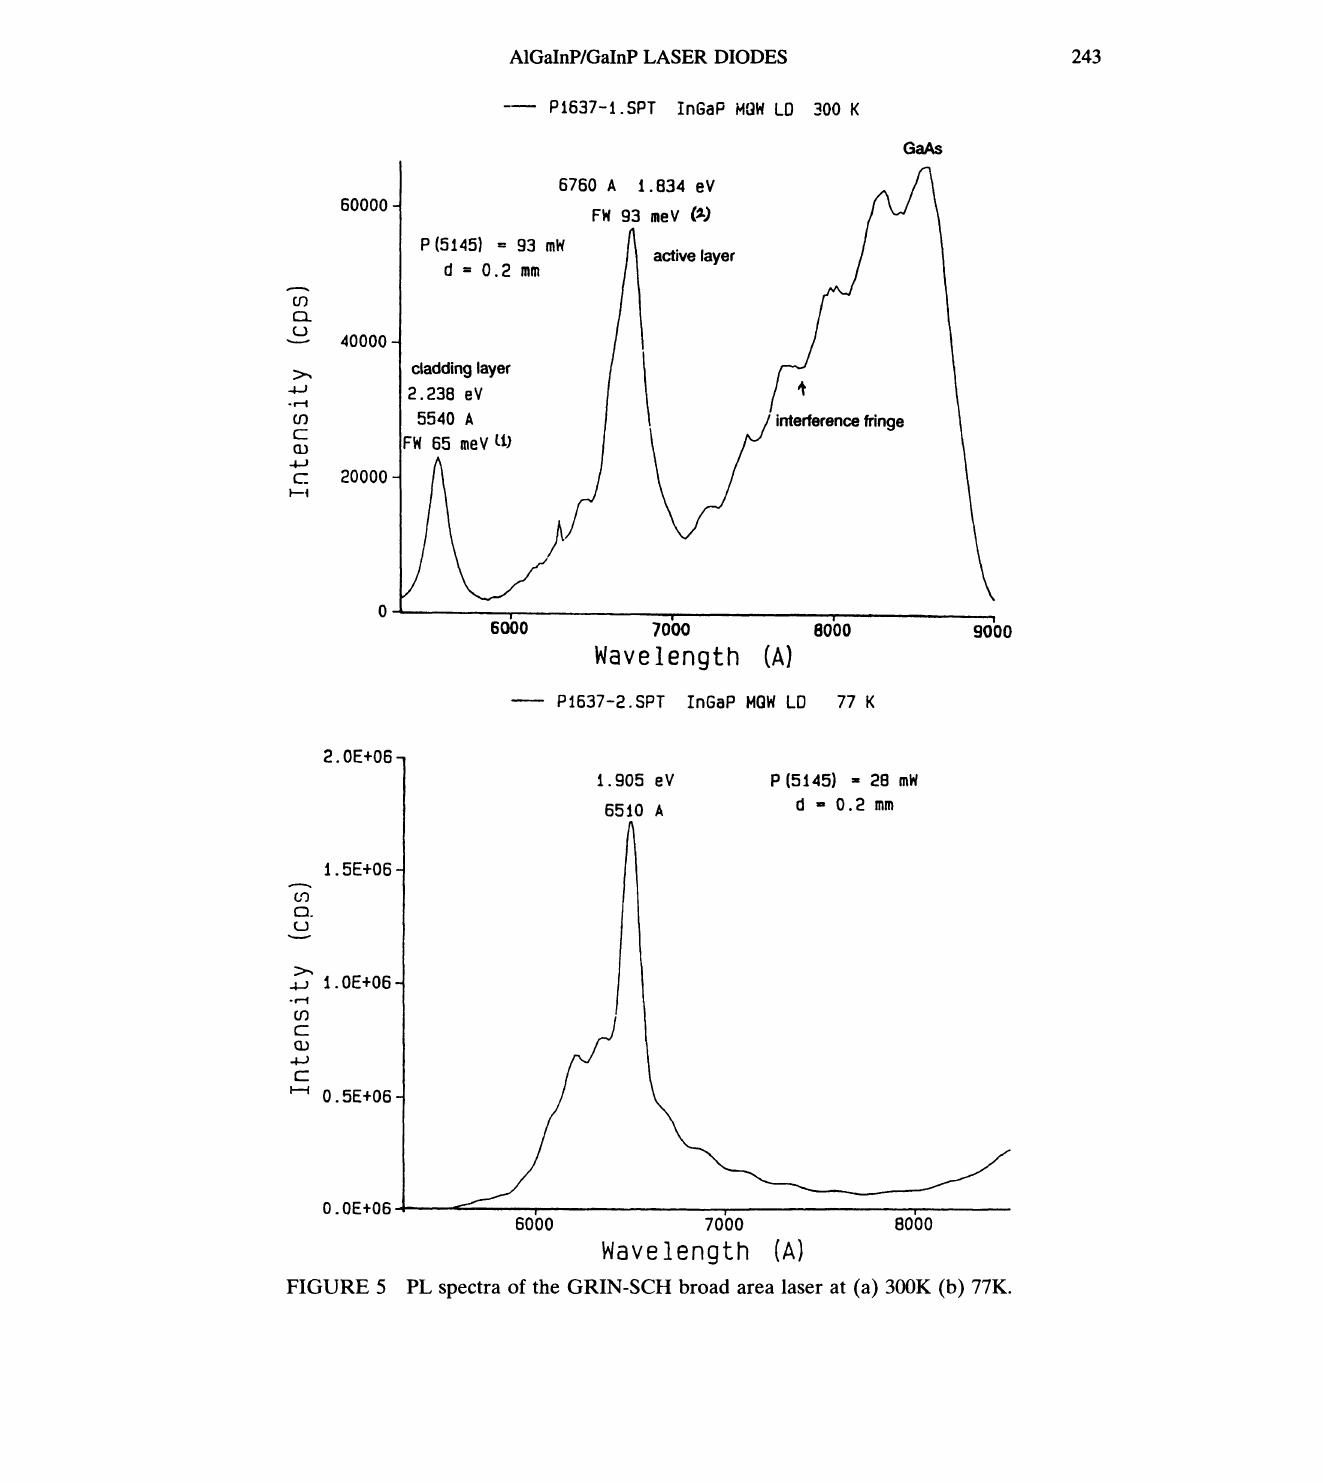
FIGURE 5 PL spectra of the GRIN-SCH broad area laser at (a) 300K (b)